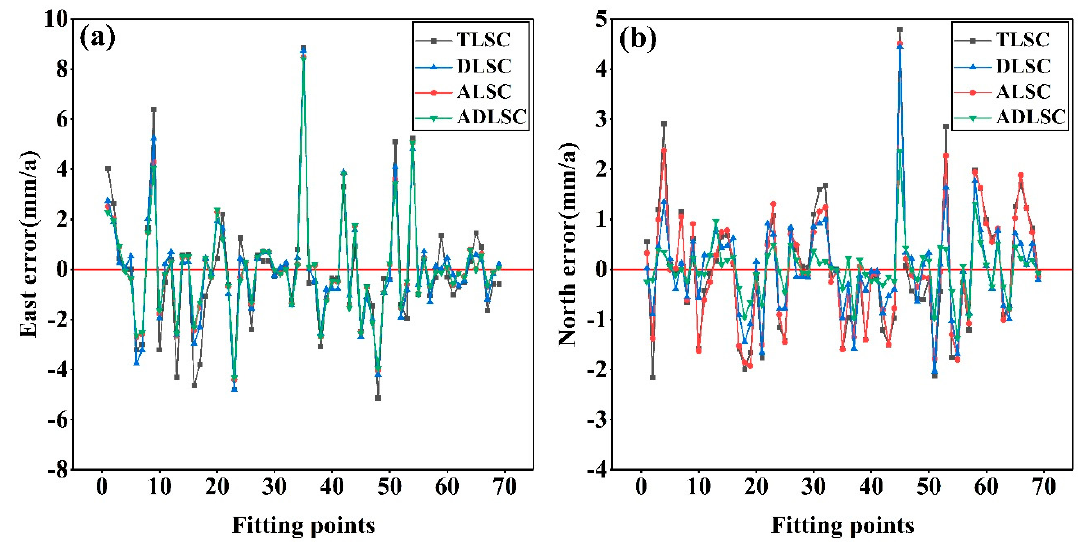
Figure 4. Residual between the estimated and observed velocity of the fitting points in the ( a ) east and ( b ) north.